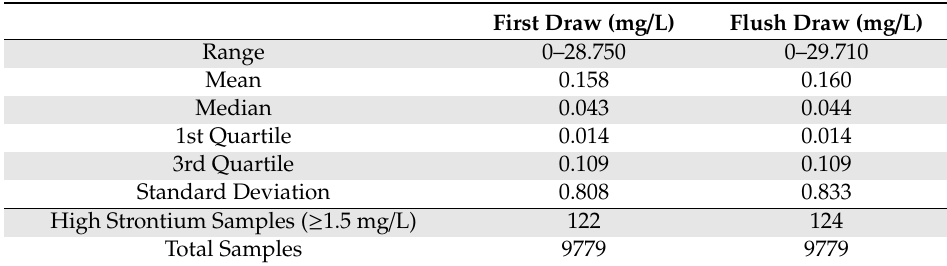
Table 1. Statistical summary of strontium first and flush draw samples. First Draw (mg /